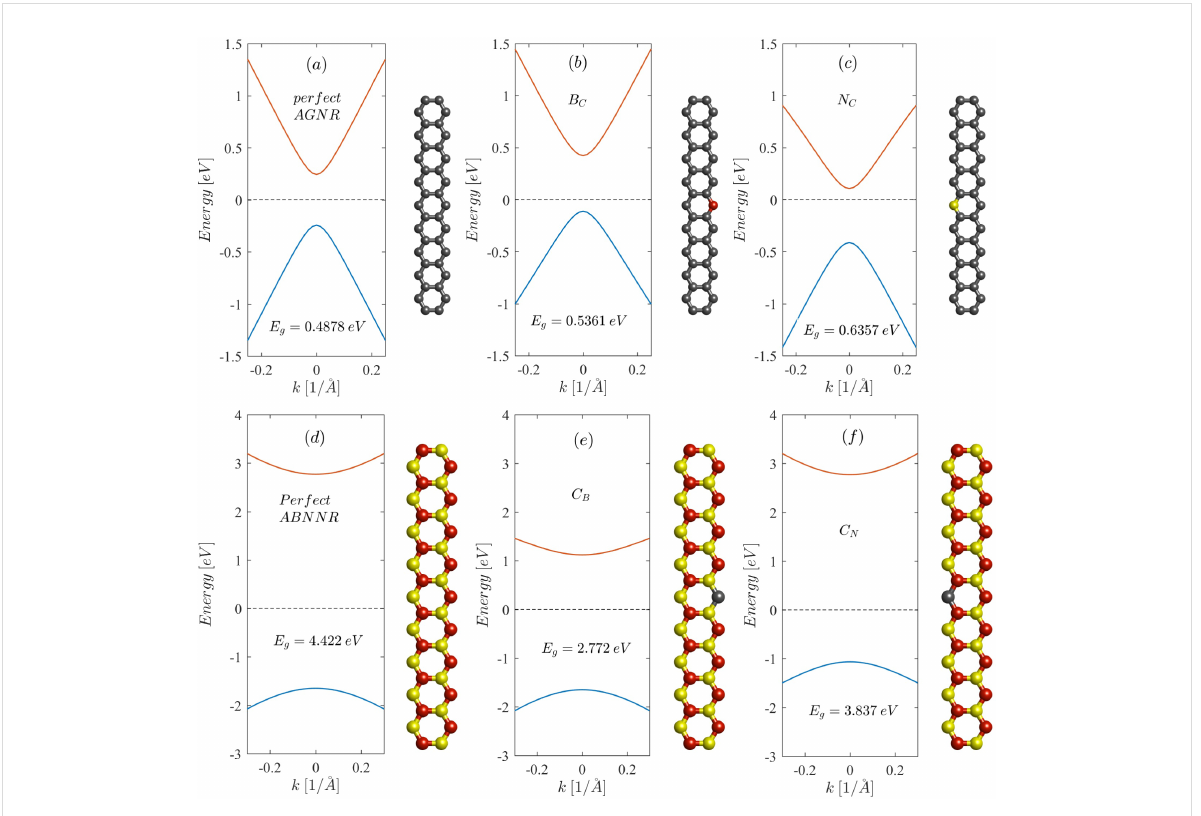
Figure 3: Effect of substitutional defects on the energy bandstructure of 19-AGNR and 19-ABNNR. Carbon, boron and nitrogen atoms are depicted in grey, red and yellow, respectively.